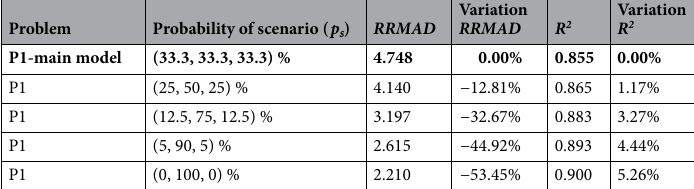
Table 10. Analyzing the probability of scenario. Significant values are in bold.